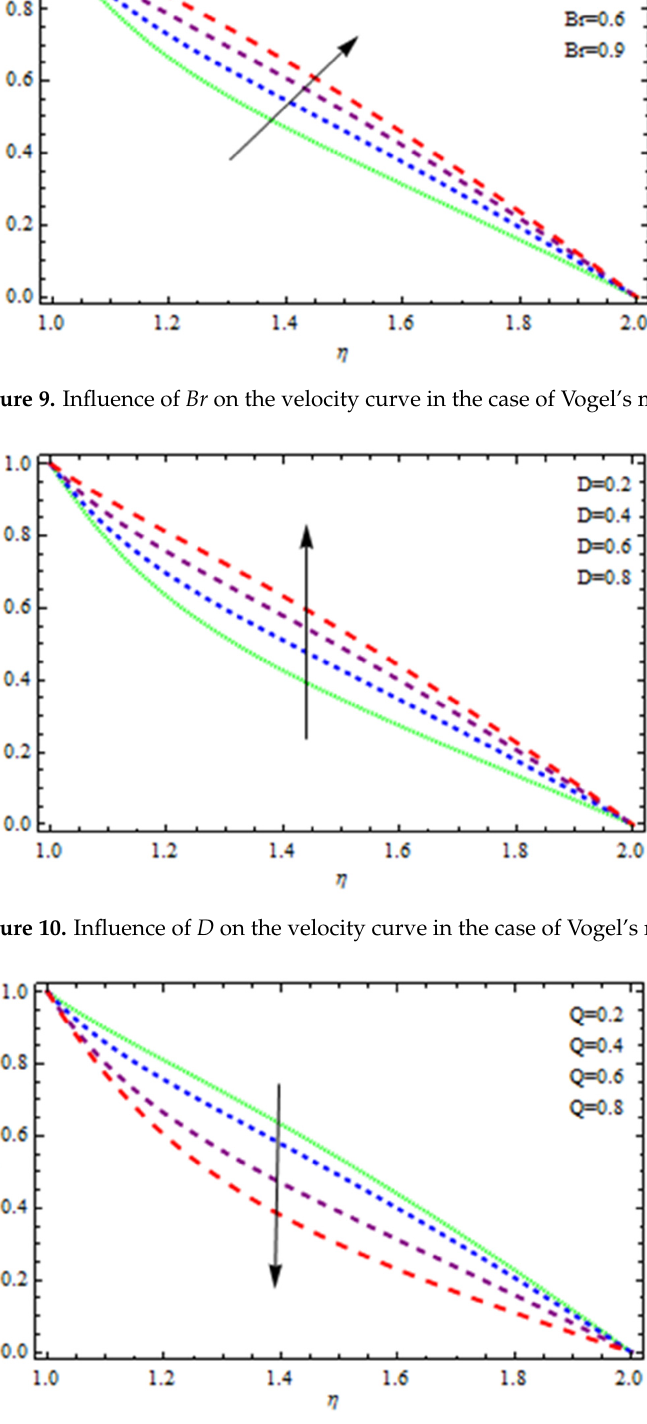
Figure 11. Influence of Q on the velocity curve in the case of Vogel’s model.